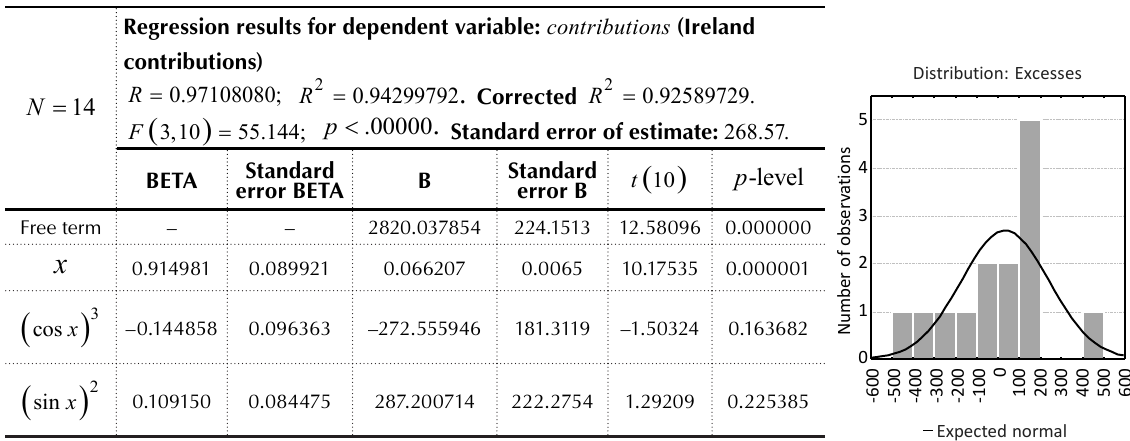
Table 6b. The results of regression for contributions of the members of the Investor Compensation Company Limited (Ireland) ( ) c from its volume ( ) x